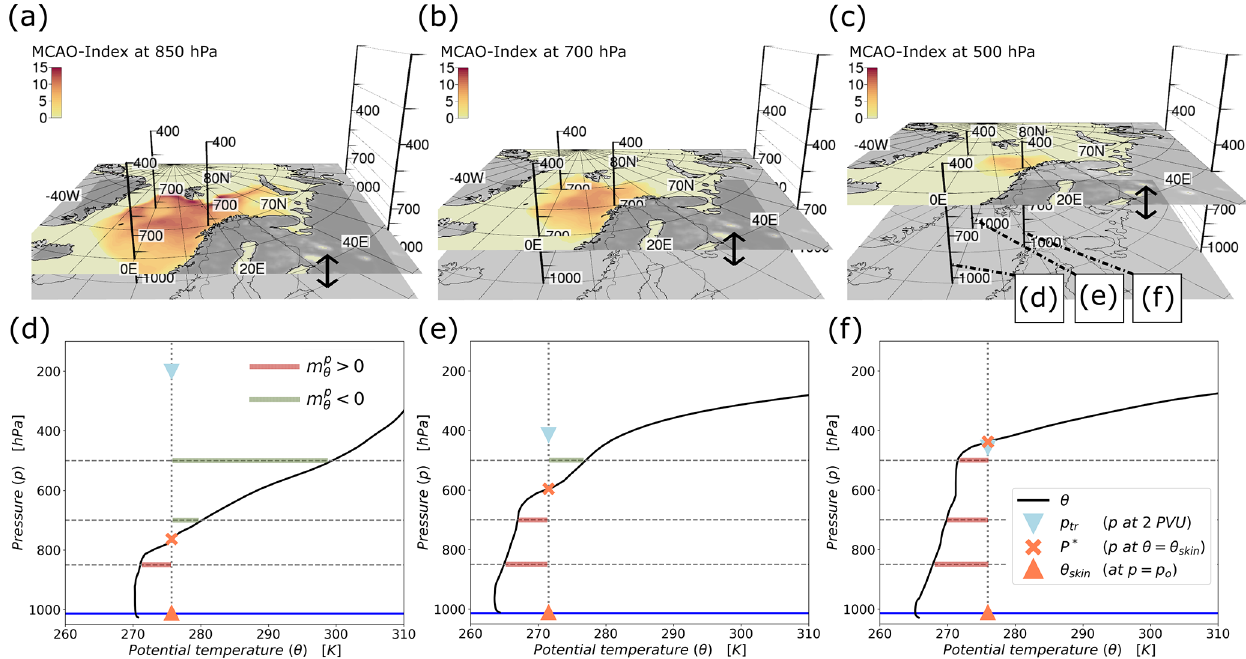
Figure 3. Extending the conventional MCAO index to 3-D. (a–c) Sensitivity of the conventional MCAO index to the choice of the character- istic pressure level. The MCAO index is calculated at 14:00UTC on 24 March 2011, for different characteristic pressure levels (i.e. Eq. 2 with different values of θ(p) ): (a) 850hPa, (b) 700hPa, and (c) 500hPa. (d–f) Vertical profiles of potential air temperature at selected locations within the MCAO (locations indicated by the poles in panels (a–c) ). The 3-D variant of the conventional MCAO index is positive below and negative above the critical pressure level, p ∗ (illustrated as an orange cross), at which θ skin = θ(p) . The red and green lines illustrate the difference in potential temperature at the pressure levels shown in (a–c) . Movie 3 demonstrates the interactive visual analysis of the effect of varying the characteristic pressure level in the conventional MCAO index. Figure 4 illustrates the 3-D structure of the MCAO shown here by visualizing the isosurface of p ∗ for the entire geographical